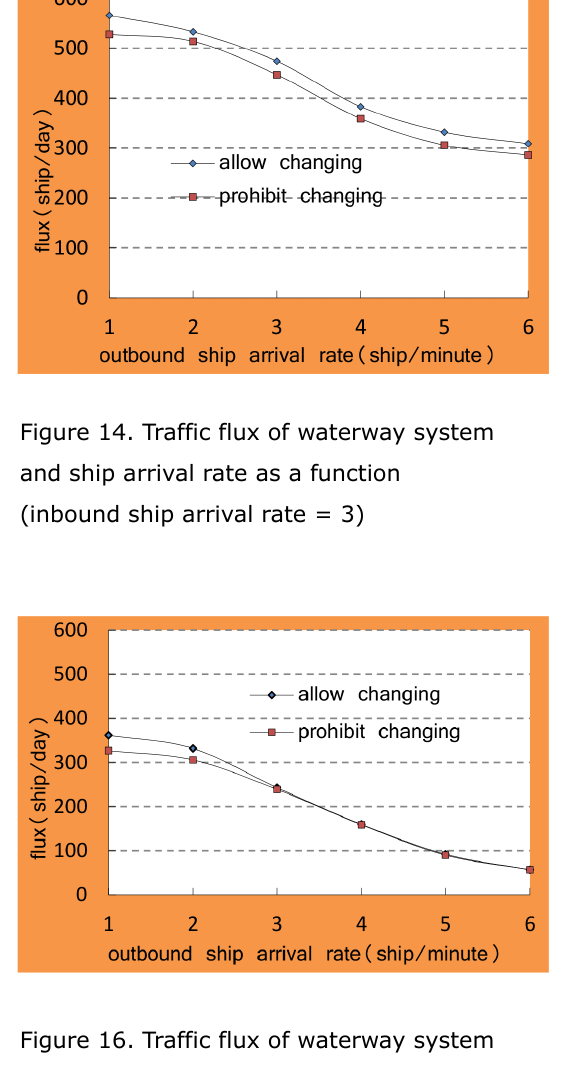
Figure 17. Traffic flux of waterway system and ship arrival rate as a